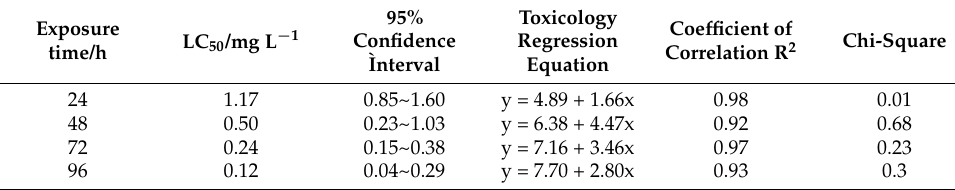
Table 5. The lethal effects of Cd2+ on D. pulex .